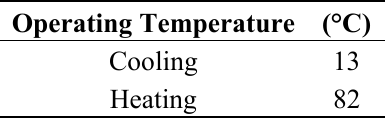
Table 3. Upper and lower dead-band operation temperatures for (cid:1846)